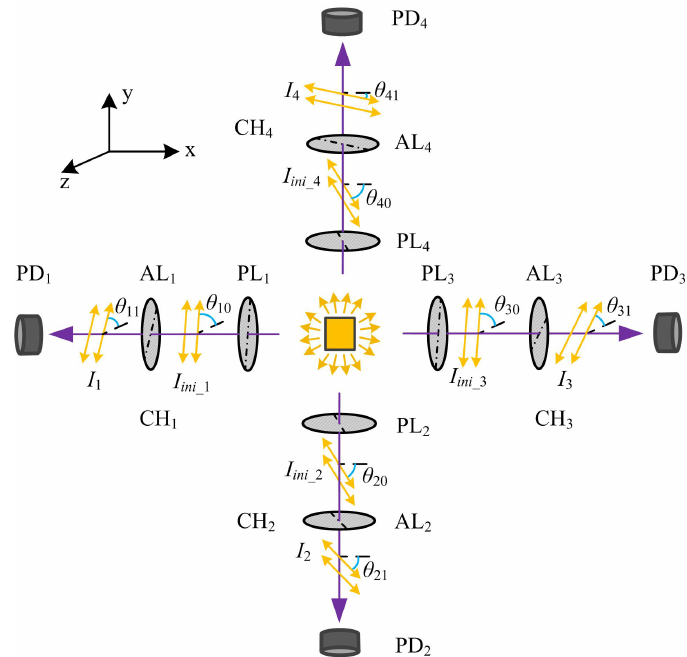
Figure 2. The schematic diagram of the optical sensor. PL i and AL i are linear polarizing films for the sensing channel CH i ( i = 1, 2, 3, and 4). PD i represents the photodiode which converts the light intensity into an electrical